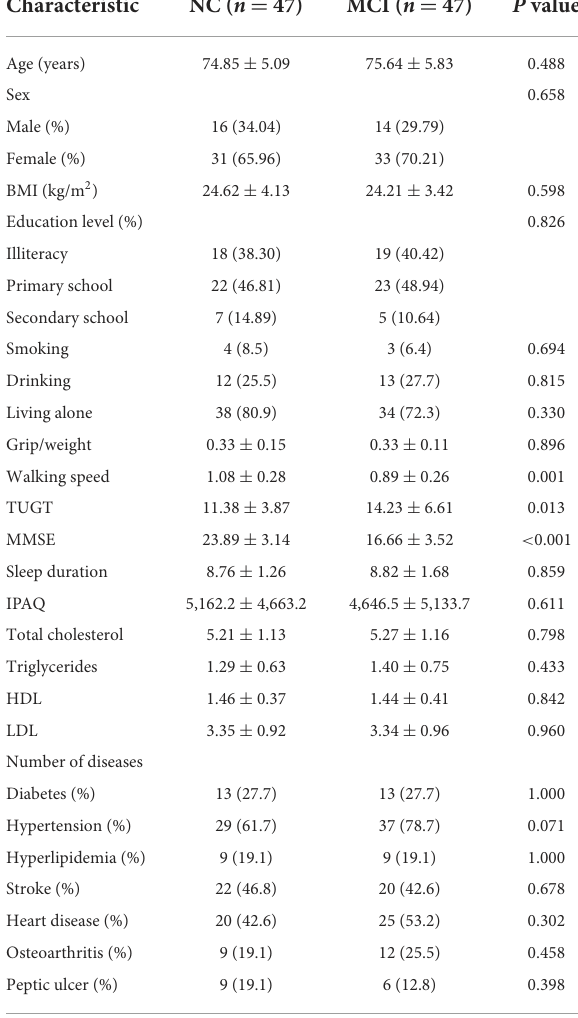
TABLE 1 Baseline sociodemographic variables of the matched groups ( N = 94).